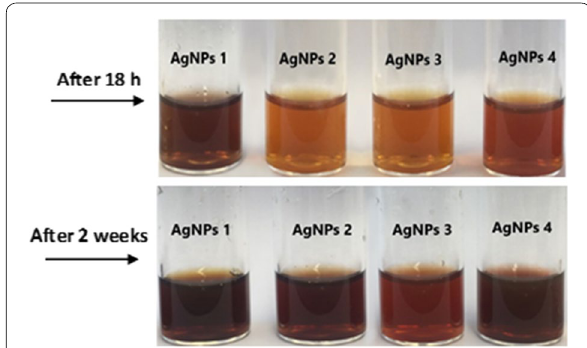
Fig. 2 The nano-suspensions were analyzed for stability and change in color with the passage of time and the results confirm the unstable nature of the samples